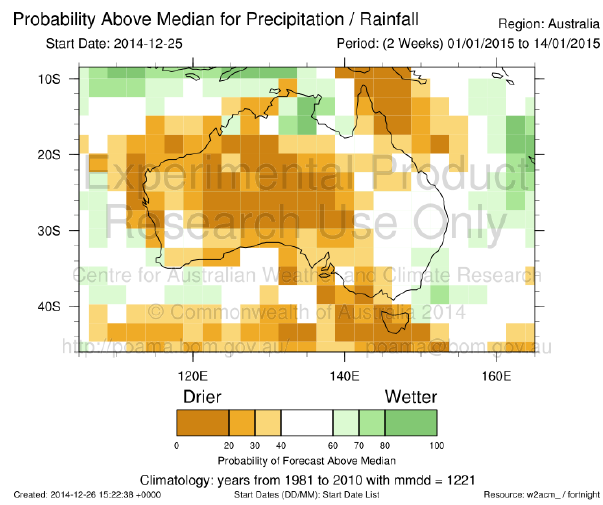
Figure 1. Example of an experimental POAMA subseasonal rain- fall forecast for weeks 2 and 3 combined, showing probability of rainfall above median (obtained from the Bureau of Meteorology POAMA website: